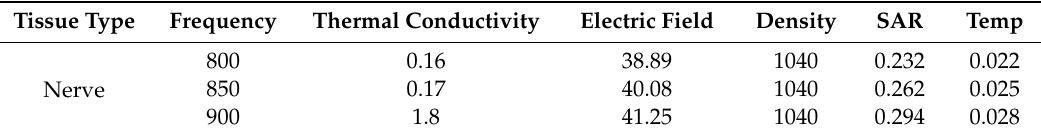
Table 3. Simulation